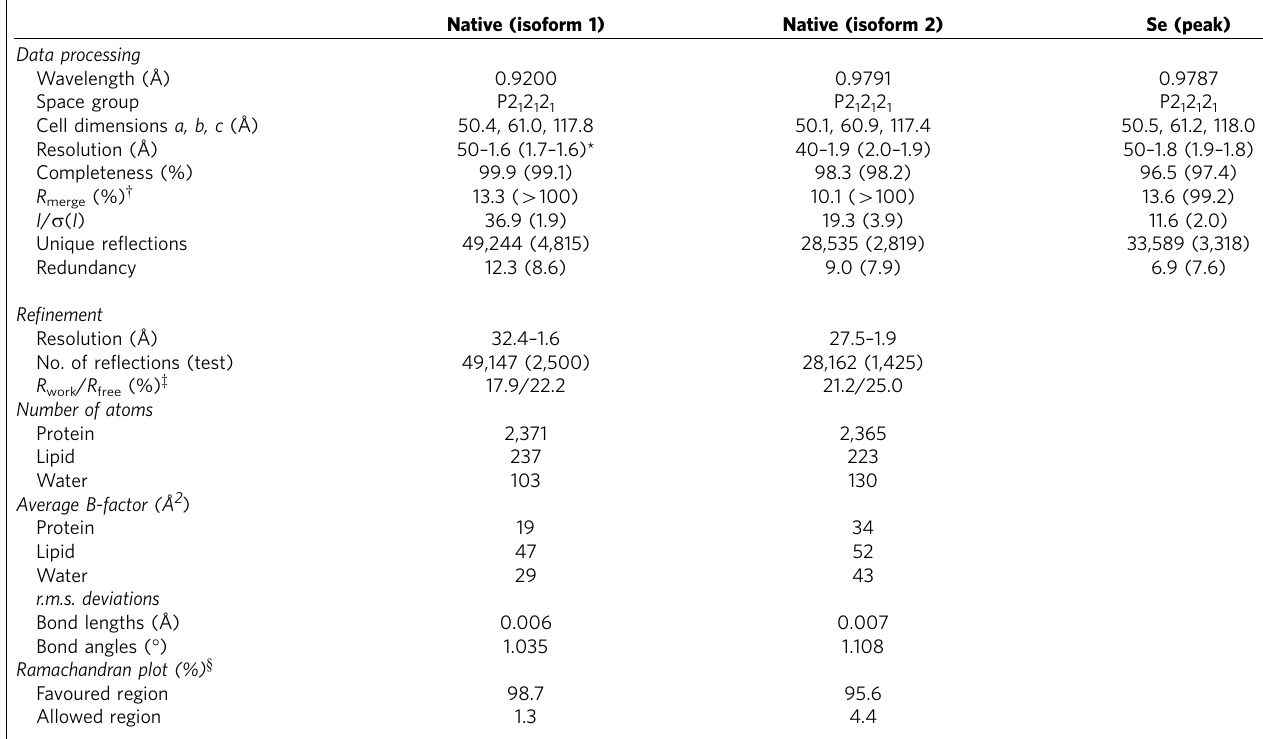
Table 1 | Statistics of data collection and